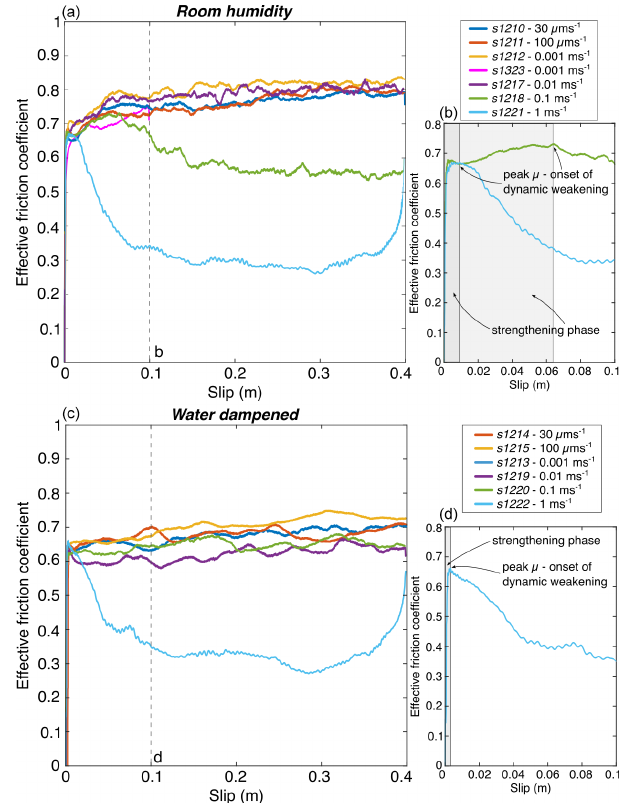
Figure 2. Effective friction coefficient in mixed calcite–dolomite gouges. (a, c) Effective friction coefficient versus slip under room- humidity and water-dampened conditions. (c, d) Detail of effective friction coefficient versus slip in the first 0.1m of slip in experi- ments where slip weakening was